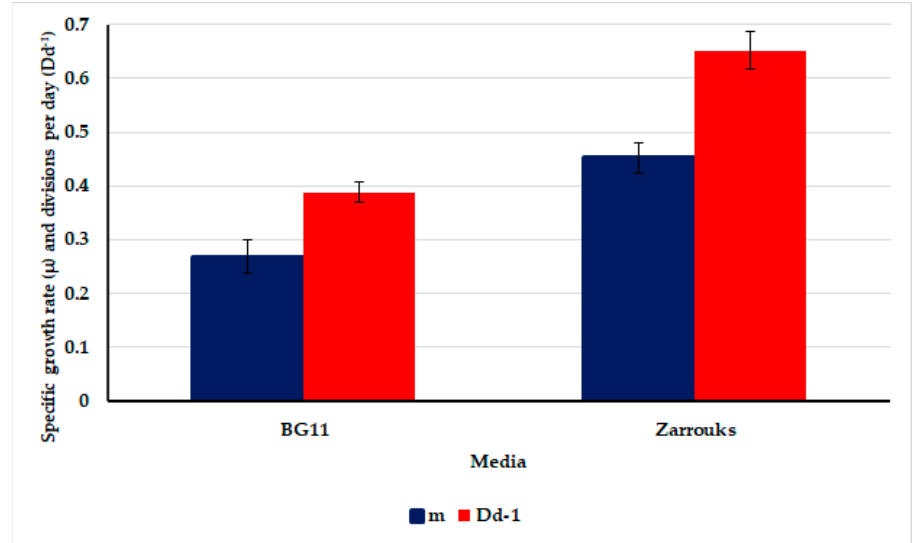
Figure 3. Specific growth rate (µ) and divisions per day (Dd − 1) of O. sancta grown on BG 11 and Zarrouk’s media. Values are the averages of three replicates ± standard deviation.